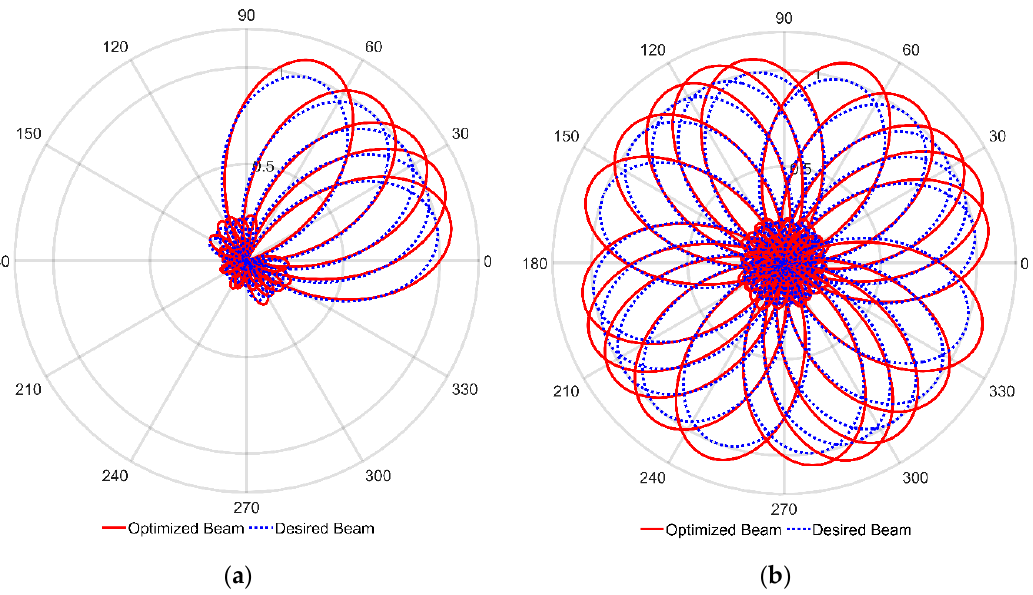
Figure 13. Beam Patterns of Two-Square Configuration 2: ( a ) Beam to random angles 10°, 22.5°, 35°, 50°, and 70°, ( b ) Rotated beams.